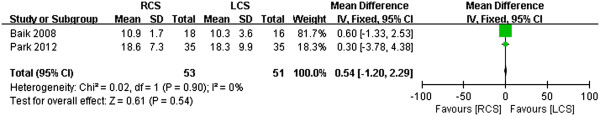
Meta-analysis of the proximal margins shown as a forest plot between robotic-assisted colorectal surgery (RCS) and laparoscopic colorectal surgery (LCS). The mean differences with the 95% CIs are shown.